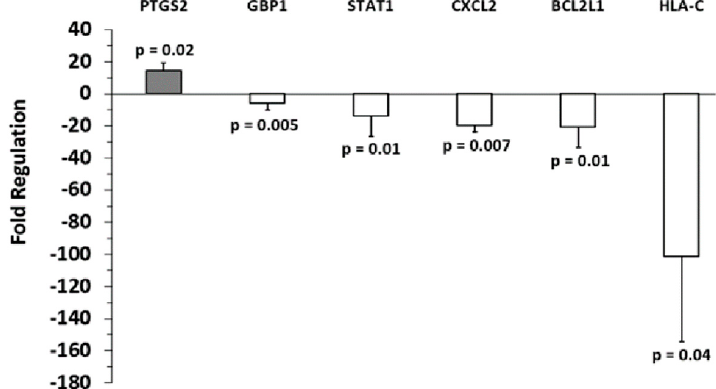
Figure 4. Fold regulation of SKMEL-28 melanoma sEV mRNA versus control primary melanocyte sEV mRNA. ( a ) Increased and ( b ) decreased gene expression levels relative to primary melanocytes (normalized to 1) are shown. Three independent sEV batches were pooled and run on ( n = 3) replicate arrays, error bars = SD, p values <0.05 were considered statistically significant.